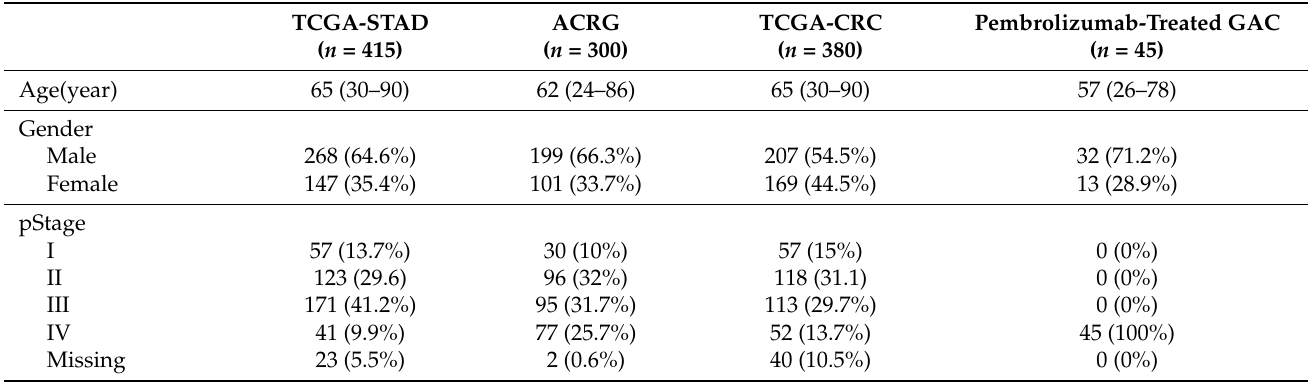
Table 1. Baseline